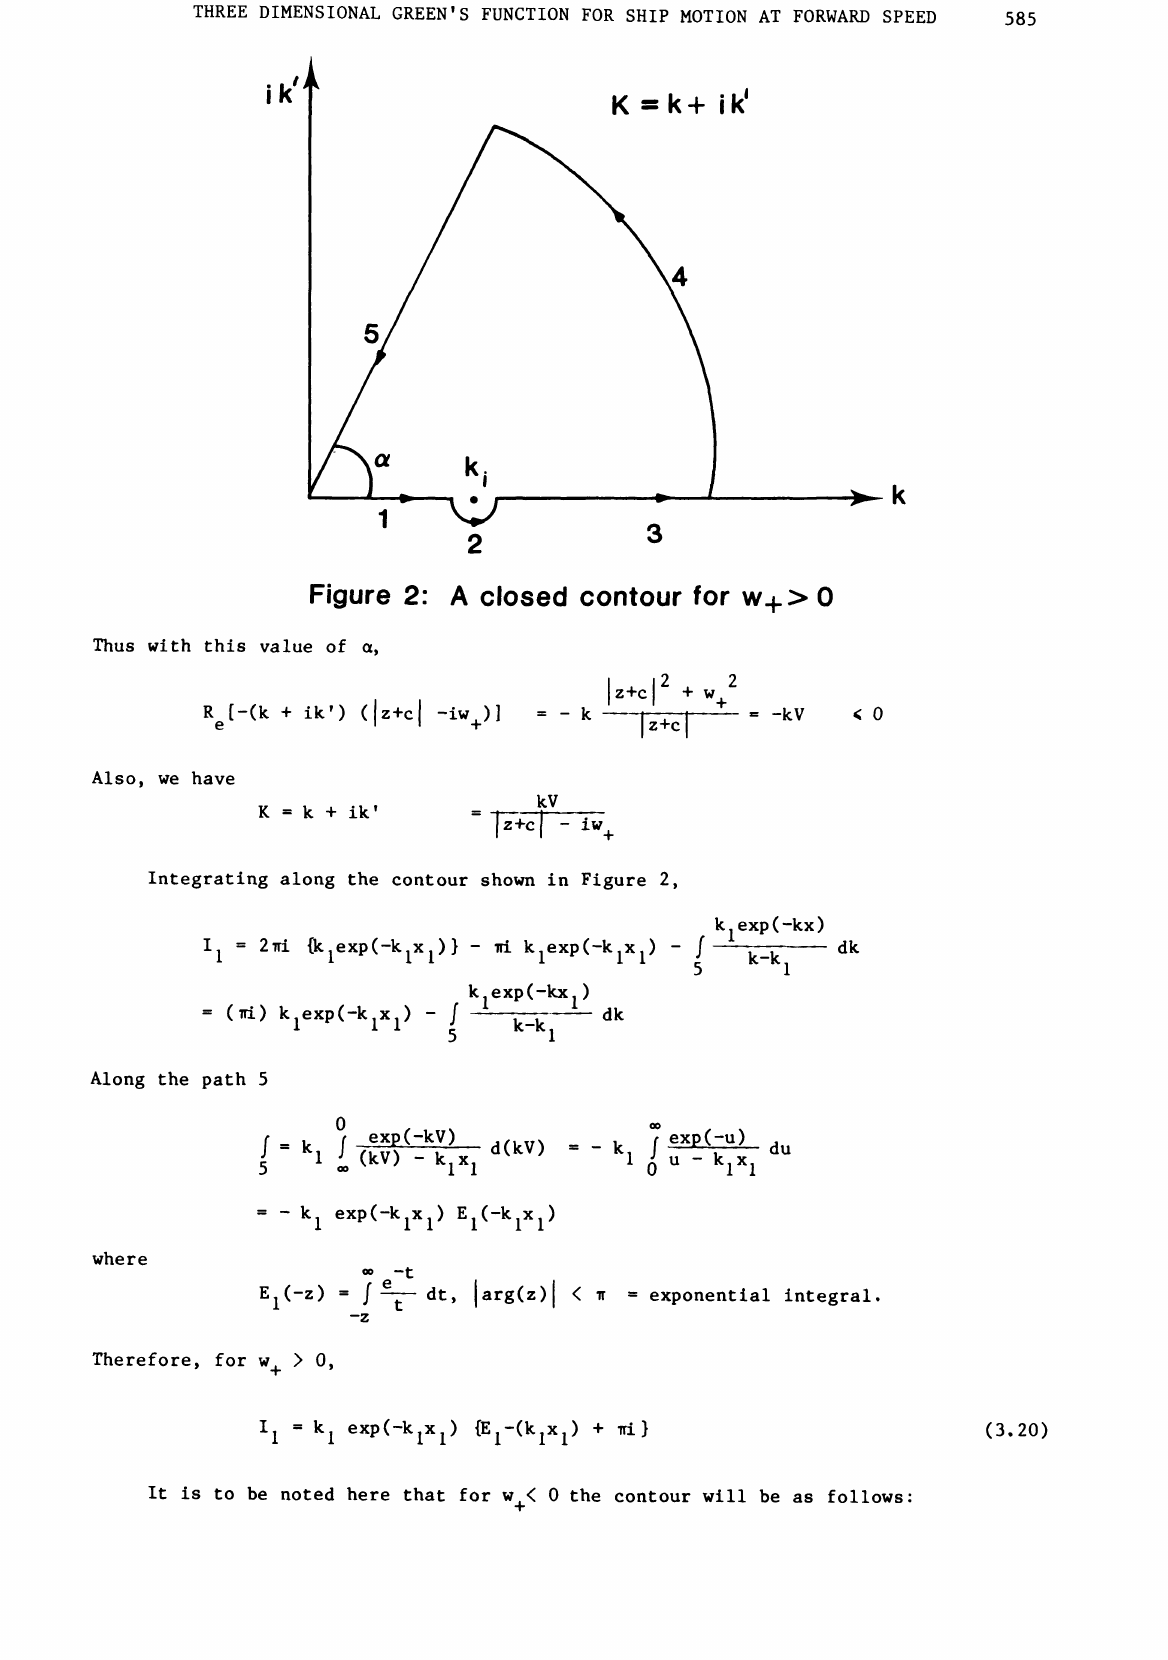
Figure 2" A closed contour for w+>